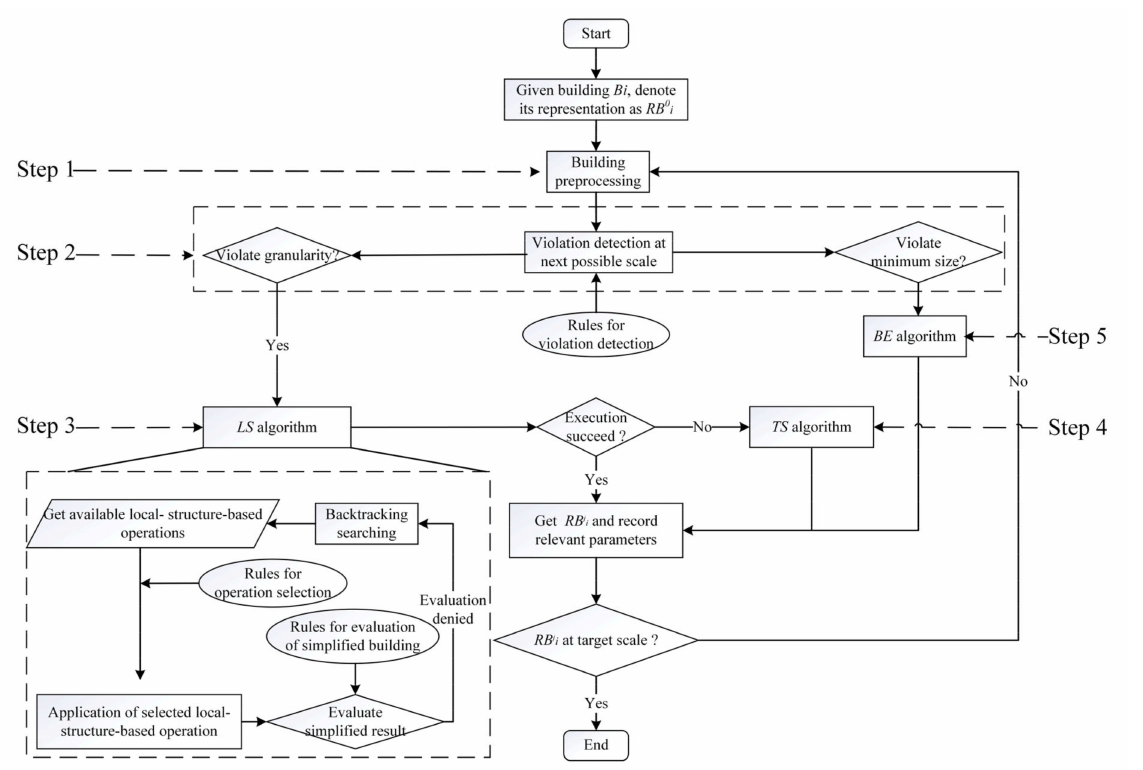
Figure 2. Framework of our